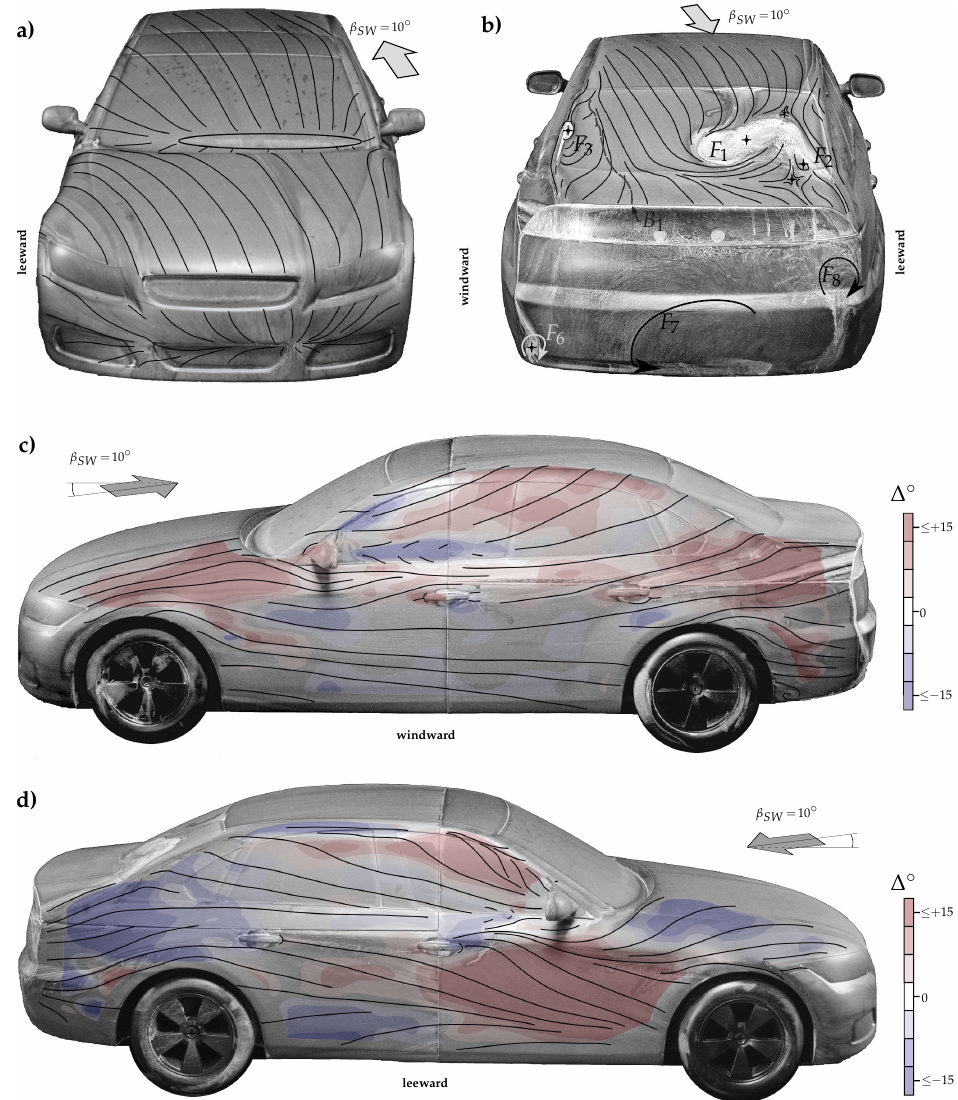
Figure 6. Surface traces at side wind condition of 10 ◦ : ( a ) front view, ( b ) rear view, ( c ) leeward side, and ( d ) windward side. The color indicates the changes in the oil trace directions in relation to the baseline case.